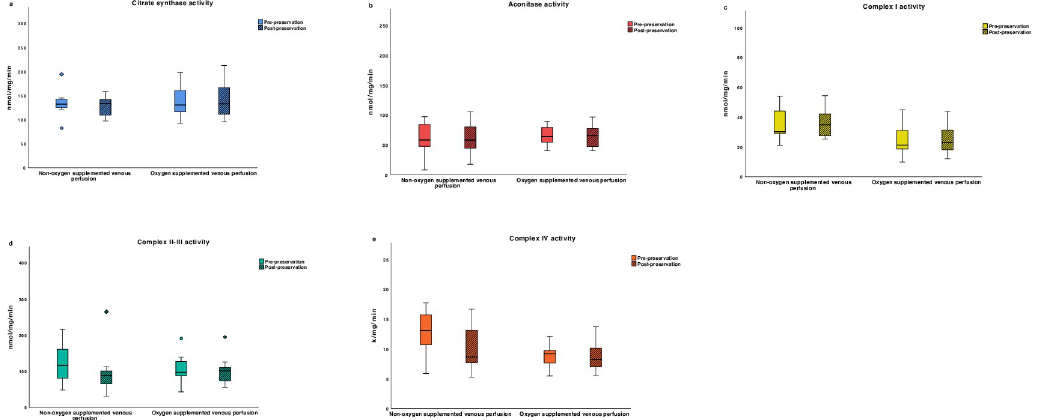
Fig 3. Box whisker plots of mitochondrial enzyme activities in stage 2. The plots demonstrate the distribution of enzyme activities round the median in each group, shown before and after 4-hr end-ischaemic hypothermic machine perfusion. The change in enzyme activities was not significantly different between preservation groups (p > 0.05). Top and bottom whiskers represent the maximum and minimum values, respectively. Circles represent outliers (1.5 to 3x interquartile range) and diamonds represent extreme outliers ( > 3x interquartile